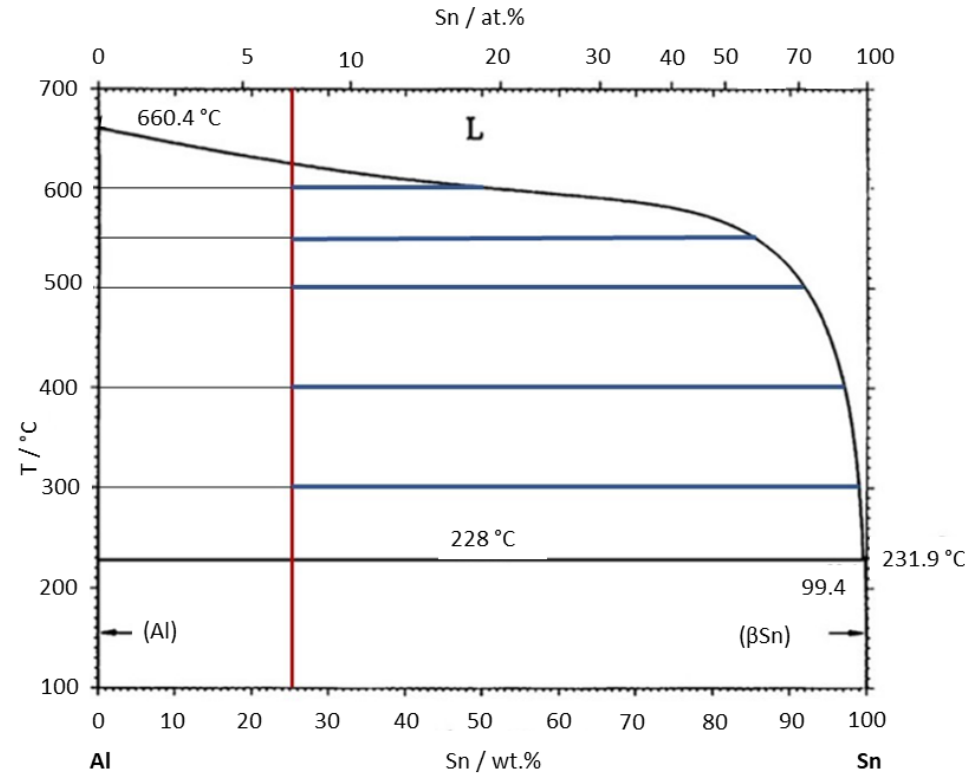
Figure 9. State diagram of the Al-Sn system [15].